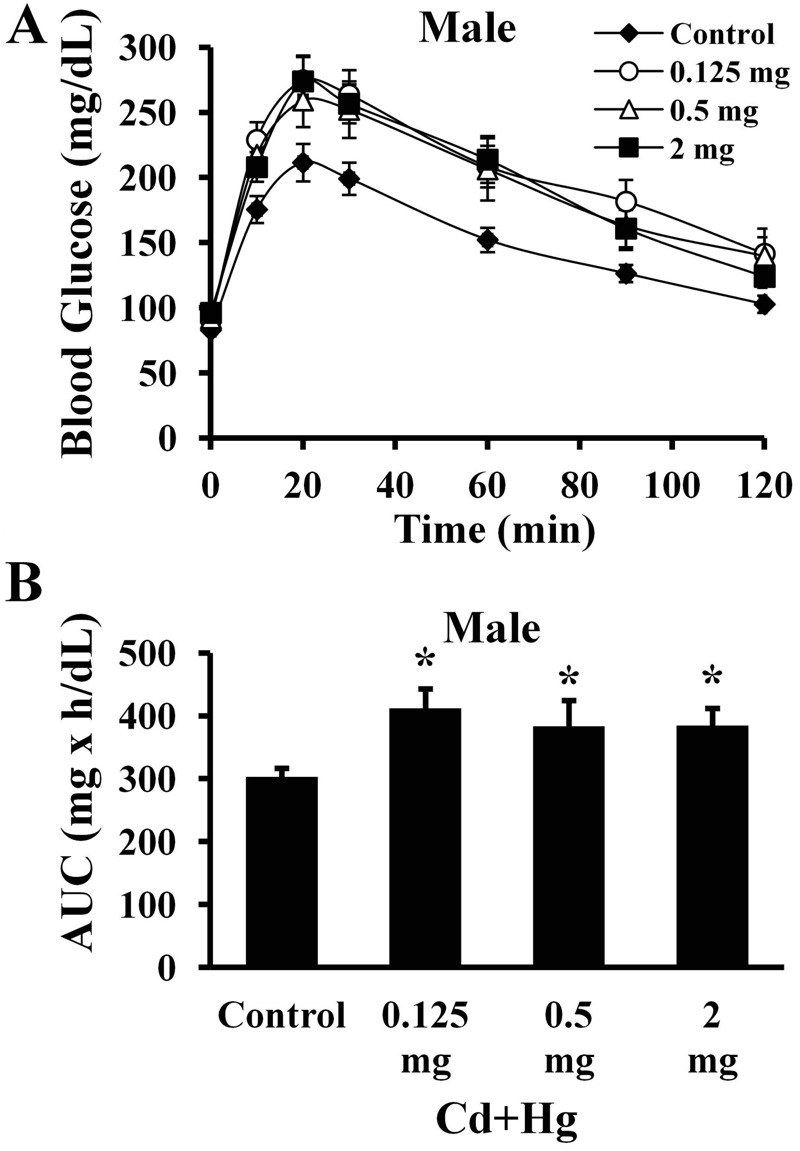
GTT and AUC values for 12-week-old male offspring. (A) Glucose tolerance of male offspring (n = 15 per treatment). The x-axis represents experimental duration in minutes and the y-axis represents blood glucose concentration in mg/dL. Significant differences over time between treatment and control offspring were tested (p < 0.05 compared with controls). (B) AUC values (*p < 0.05 compared with controls). The x-axis represents each treatment group. The y-axis represents AUC values for plasma glucose in mg × hr/dL of blood. Note: Data are presented as mean ± SEM.